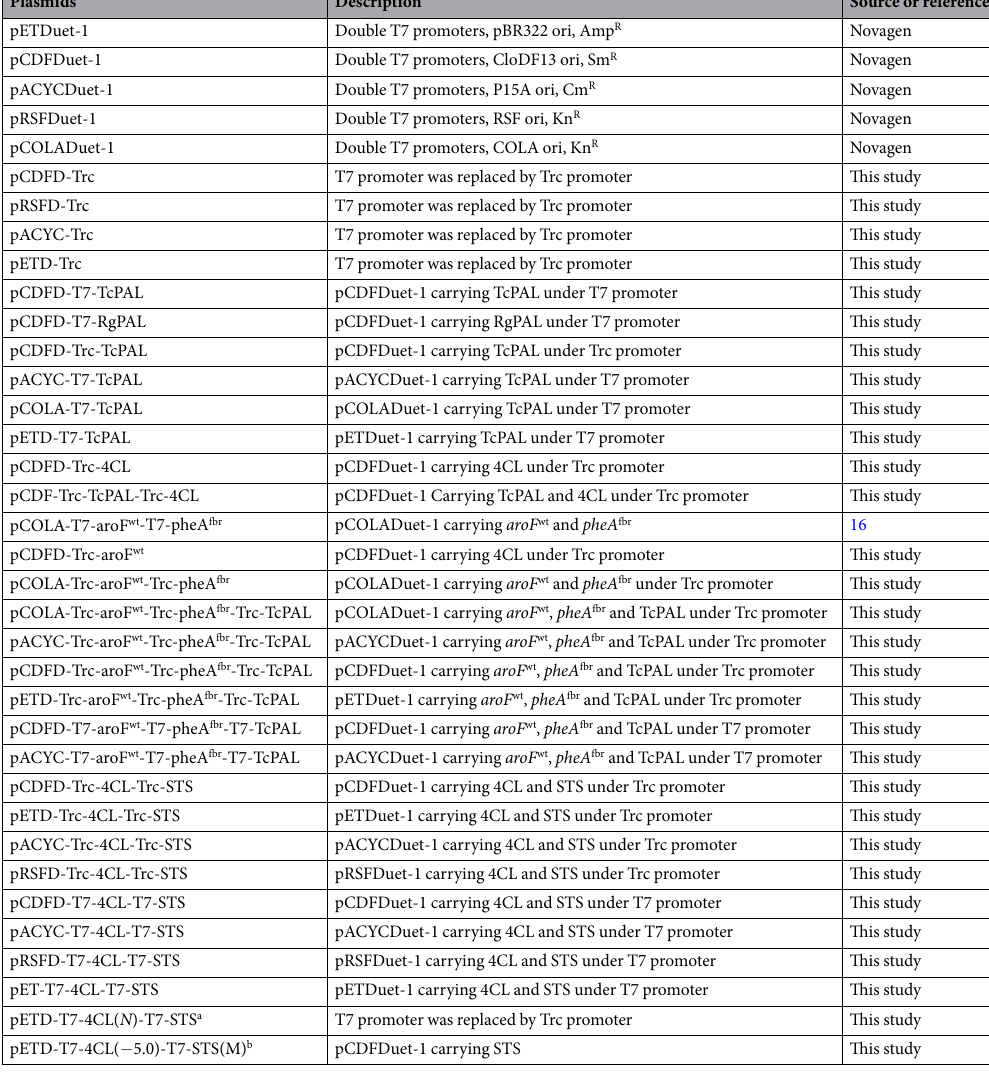
Table 3. Plasmids used in this study. a N = − 10.3, − 9.4, − 8.1, − 7.6, − 7.0, − 5.0, − 4.1. b M = − 8.0, − 6.3, − 5.1, − 4.9, −